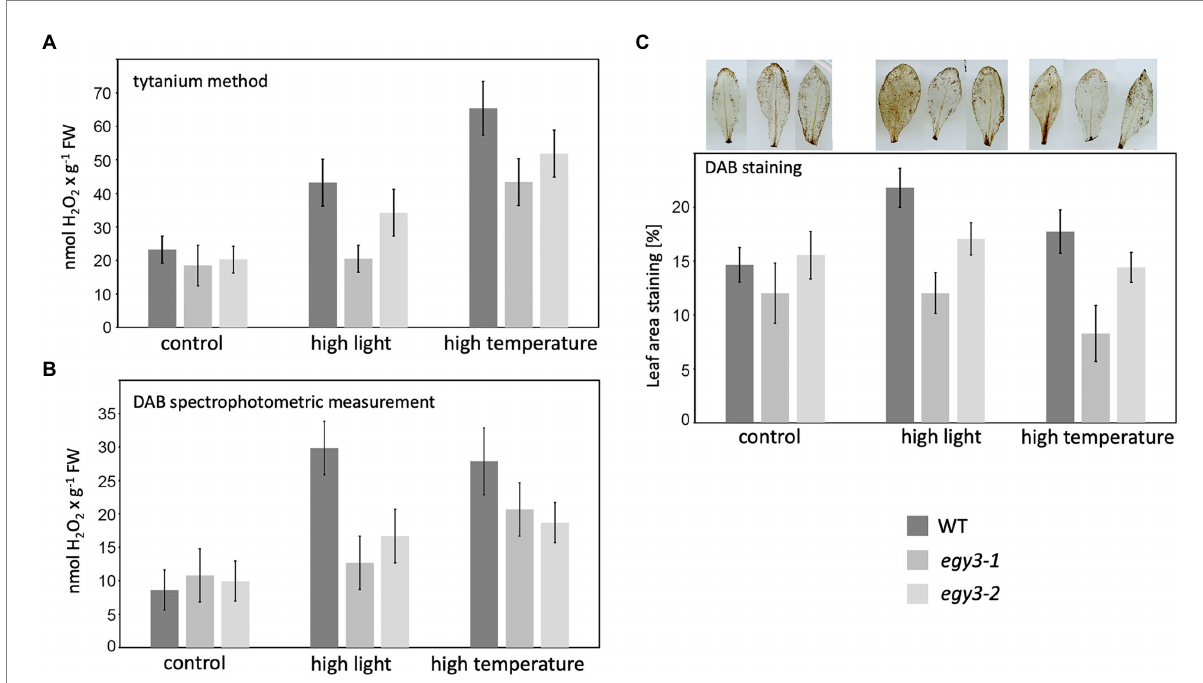
FIGURE 9 Accumulation of hydrogen peroxide in WT plants and egy3 mutant lines after 1 h exposition to high light and high-temperature stress. (A) Titanium (Ti 4+ ) method staining (B) DAB staining spectrophotometric measurement (C) percentage of leave area staining with DAB. The values presented for Titanium (Ti 4+ ) method staining and DAB staining spectrophotometric measurement are average from two biological replicates (10 plants each). The values presented for the percentage of leave area staining with DAB are average from three biological replicates (10 leaves